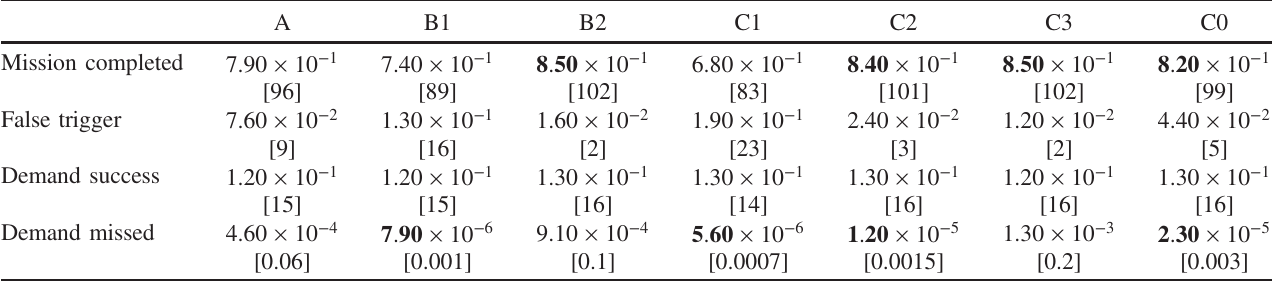
TABLE VII. Case II: Scenario probabilities for the different architectures assuming fault-free voting. Default input parameters, analytical. In brackets: number of expected occurrences during lifetime (20 years and 6 cycles per year). The four best values for Mission Completed (machine availability) and Demand Missed (machine safety) are highlighted.